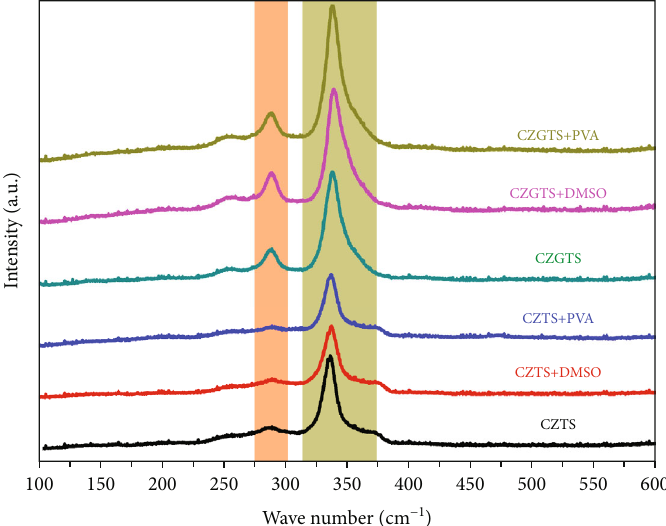
Figure 6: Raman spectrum for the CZTS, CZTS-DMSO, CZTS-PVA, CZGTS, CZGTS-DMSO, and CZGTS-PVA thin fi